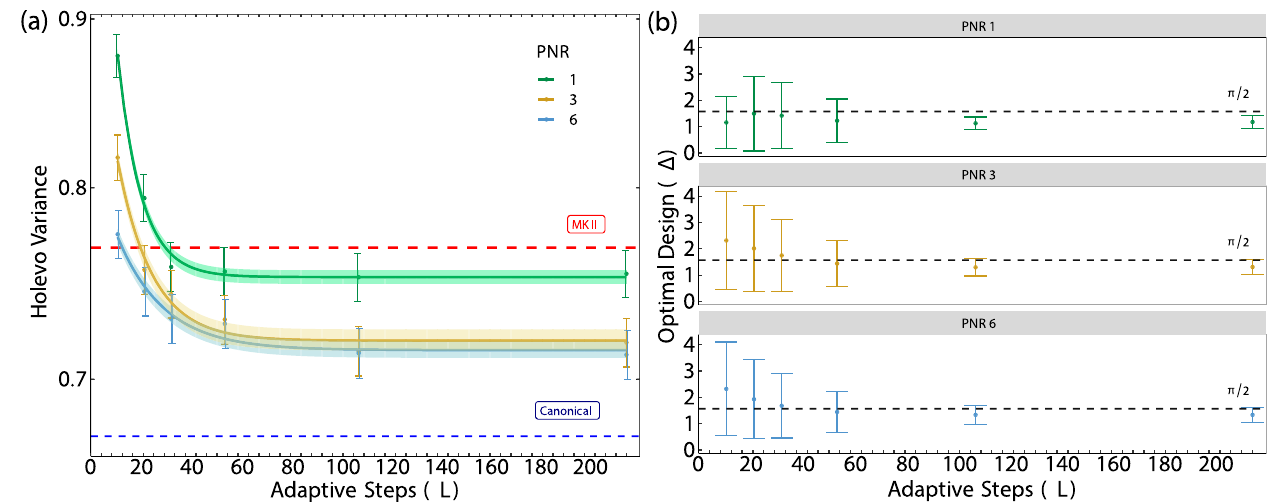
Fig. 2 Asymptotic limit for the estimator of Holevo variance and optimal design. a Holevo variance for ∣ α ∣ 2 = 1 and PNR m = 1, 3, 6 as a function of adaptive steps L . Note that the non-Gaussian strategy surpasses the MKII strategy (red dashed line at y = 0.767) with L > 100, L > 30 and L > 20 for PNR(1), PNR(3) and PNR(6), respectively. The lines are obtained fi tting the exponential model Eq. (34). Estimates for these strategies result in ( A , B , C , RSE) = (0.11 ± 0.02, 0.059 ± 0.014, 0.7145 ± 0.0030, 0.0005) for PNR(6), ( A , B , C , RSE) = (0.22 ± 0.04, 0.082 ± 0.0157, 0.719 ± 0.0040, 0.0007) for PNR(3), ( A , B , C , RSE) = (0.41 ± 0.05, B = 0.117 ± 0.013, 0.7517 ± 0.0027, 0.0005) for PNR(1). The shaded regions represent 1- σ standard deviation. b Optimal design as a function of L . As L increases the optimal design tends to π /2. Numerical data are obtained with 10000 Monte Carlo sequences. Error bars represent a 1- σ standard